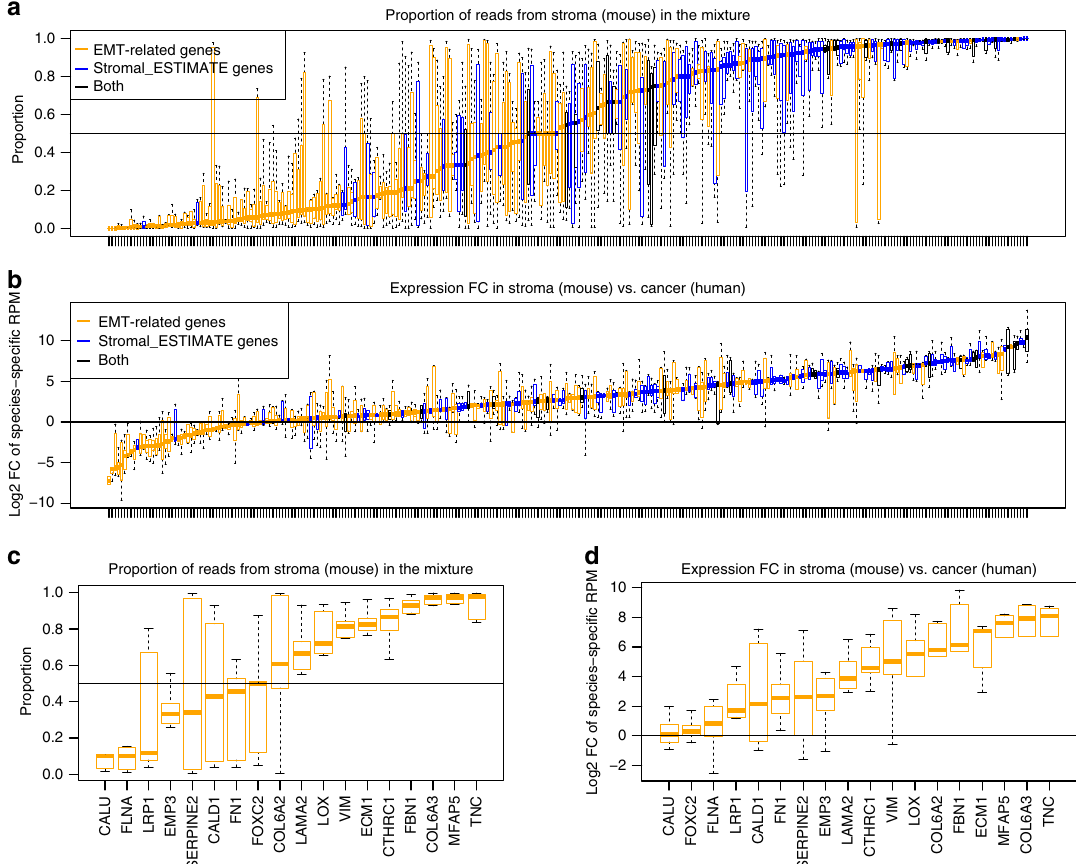
0.00.20.40.60.81.0 Fig. 5 EMT-related gene expression emanates predominantly from a stromal source in UC PDX models. a Fraction of reads mapped to mouse for each EMT-related and stromal signal gene; b Fold change of the species-speci fi c RPM value between human and mouse for each EMT-related and stromal signal gene; c Fraction of reads mapped to mouse for the top 18 EMT genes correlated with survival (EMT/Stroma_core genes); d Fold change of the species- speci fi c RPM value between human and mouse for the top 18 EMT-related genes (EMT/Stroma_core genes) correlated with survival. For boxplots, boxes extend from the fi rst to third quartiles, middle line shows median, whiskers extend to the most extreme data point which is no more than 1.5 times the interquartile range from the box, open circles show individual values that are more than 1.5 times the interquartile range from the manually counted the number of CD8 expressing cells located intratumorally vs. in the peritumoral stroma. As shown in Fig. 7, specimens with higher vs. lower EMT/Stroma_core gene expres-